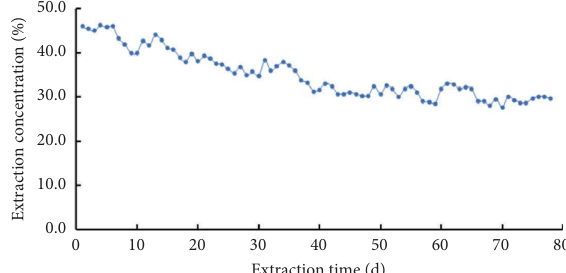
Figure 16: Change curve of extraction concentration.